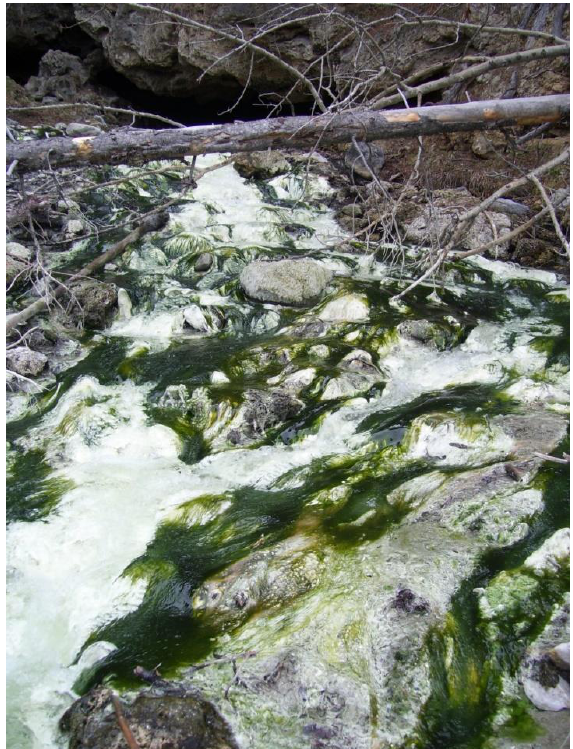
Figure 2. Sulfur Mountain thermal springs, Banff, Alberta, Canada. Outflow temperature is approximately 45 °C. The microbial mat forming community is comprised primarily of Spirulina (green) and Thiothrix like (white) microorganisms. (Archives of V. Yurkov laboratory. Used with permission.